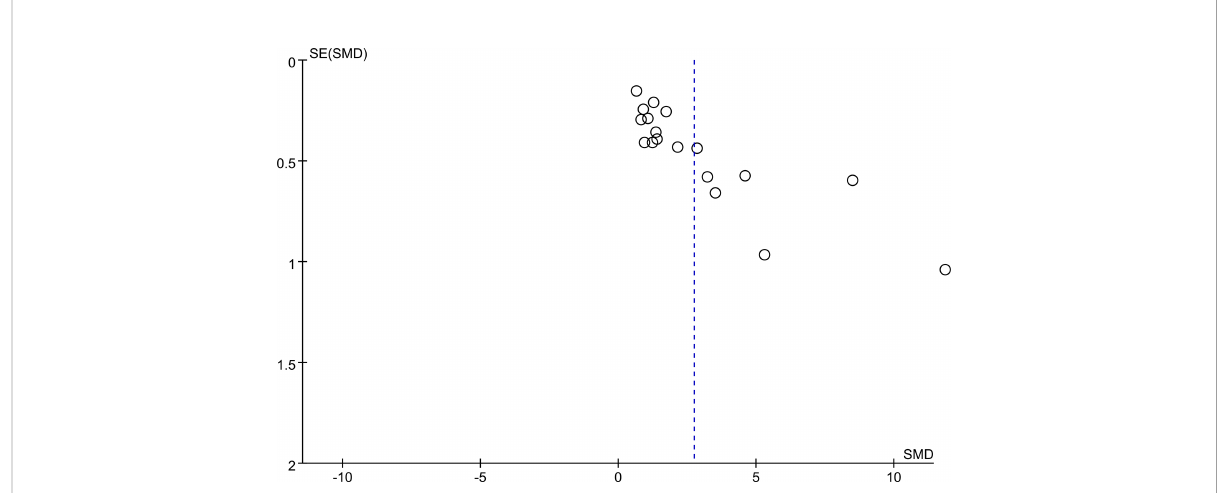
FIGURE 4 Begg ’ s funnel plot was to evaluate the publication bias among those included literatures about the association between KL-6 level and